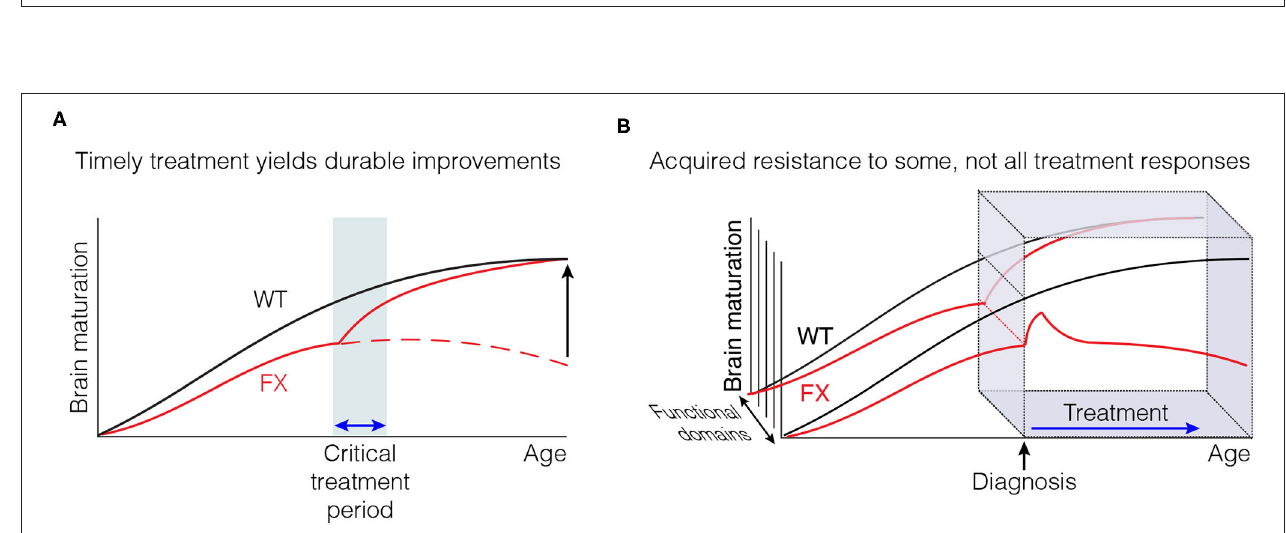
FIGURE 7 | Timely therapeutic interventions have the potential to correct the derailed postnatal development of some cognitive functions. (A) Some improvements may not be immediately apparent, but emerge with time after treatment is discontinued. (B) Some measures of improvement may not be as susceptible to acquired treatment resistance as